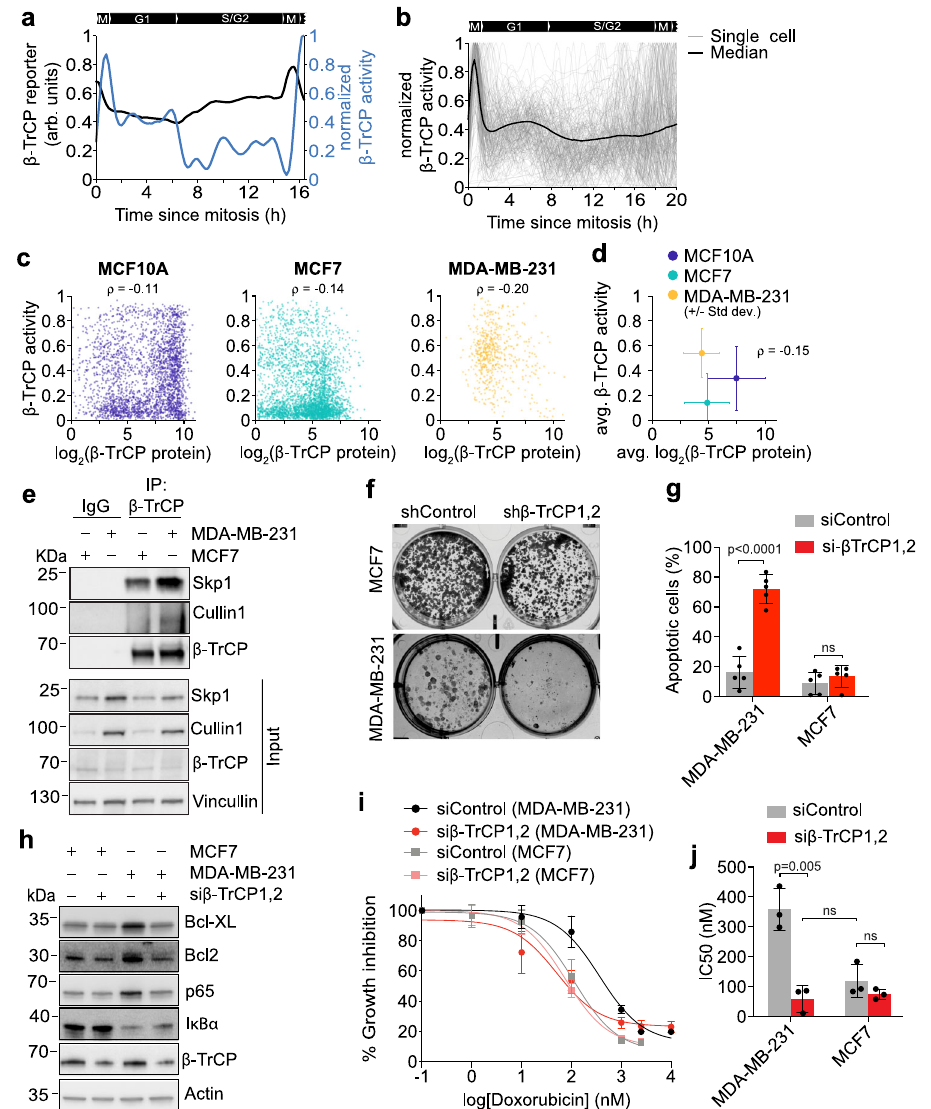
β -TrCP1,2 shRNA. Representative image from n =3 experiments. g Bar graph showing the mean percentage of Annexin-V5 positive cells from Supplementary Fig. 5j. Error bars represent SD from n =5 experiments. P values were calculated using a two-way ANOVA and Sidak ’ s multiple comparisons test. n.s. not signi fi cant ( p =0.94). h Immunoblotting of NF-kB target genes (Bcl-XL, Bcl2, p65) in MCF7, MDA-MB-231, and MDA-MB-231 cells treated with β -TrCP1,2 siRNA. Representative blot from n =3experiments. i Percentgrowthinhibition of MCF7and MDA-MB-231 cells, treated with different doses of doxorubicin. Cells were treated with either controlsiRNAor β -TrCP1,2siRNA.ErrorbarsrepresentSEMfrom n =3experiments. j Bar graph showing the mean IC50 of the dose – response curves in ( i ). Error bars represent SD from n =3 experiments. P values were calculated using a one-way ANOVA. n.s. not signi fi cant ( p =0.69 and p =0.88 respectively). Source data for all fi gure panels are provided as a Source Data fi